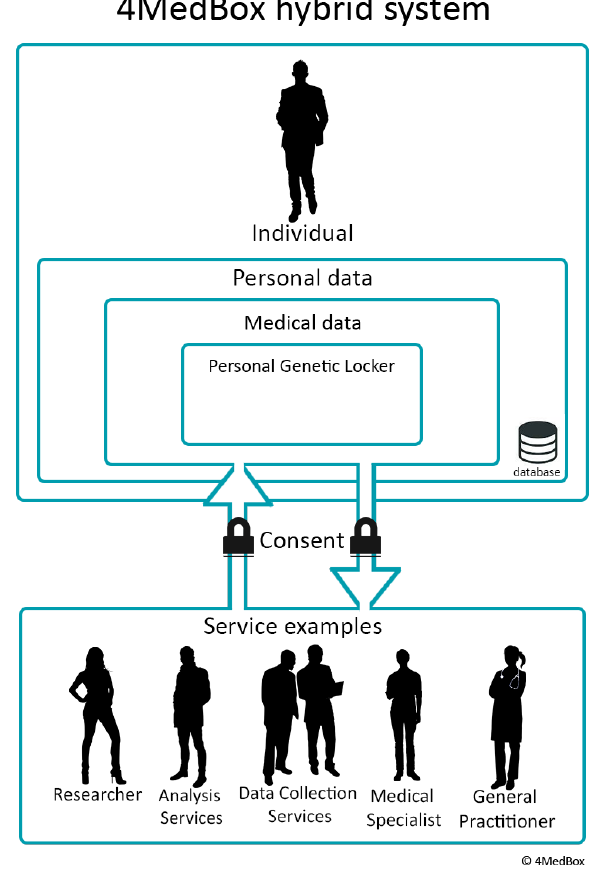
Figure 1. Schematic overview of the Personal Genetic Locker. The interaction between an individ- ual and possible medical services. The image visualizes control over the data by the individual by giving consent. Reprinted from “Using personal genomic data within primary care: a bioinformatics approach to pharmacogenomics” [31]. Copyright 2020 by Overkleeft, R. Reprinted with permission.